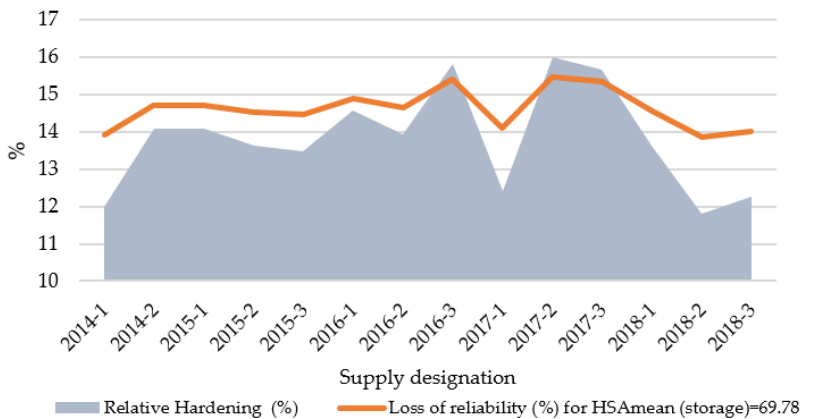
Figure 13. Relative hardening and loss of reliability (stored versus recently manufactured material).